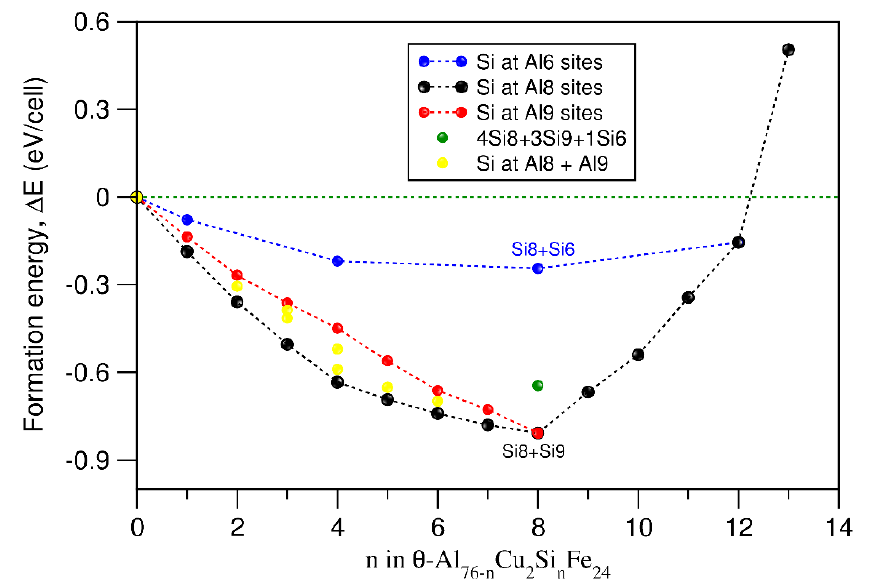
Figure 1. The calculated formation energies on Si contents (n) in θ -Al 76- n Cu 2 Si n Fe 24 with respect to θ -Al 76 Cu 2 Fe 24 and the elemental solids Al and Si (Equation (2). In the figure, the (n Si m) was used to represent the condition of the calculation. ‘n’ means the number of Si atoms, and ‘m’ the Al sites. In details, the marks represent the formation energies for the configurations with (the order of) Si atoms at the corresponding Al sites: The black filled spheres represent the formation energies relating to that Si atoms first occupy the Al8 sites and gradually the Al9 sites secondly, and the Al6 at last, the red spheres that Si atoms occupy the Al9 sites first and gradually the Al8 sites secondly, the blue spheres that Si first occupies the Al6 sites and gradually the Al8 sites secondly, and the Al9 at last. The yellow spheres represent the formation energies with the configurations with Si atoms at the Al8 and Al9 sites in a mixed way. The green sphere represents the formation energy of the 4Si8, 3Si9 and 1Si6 configuration.